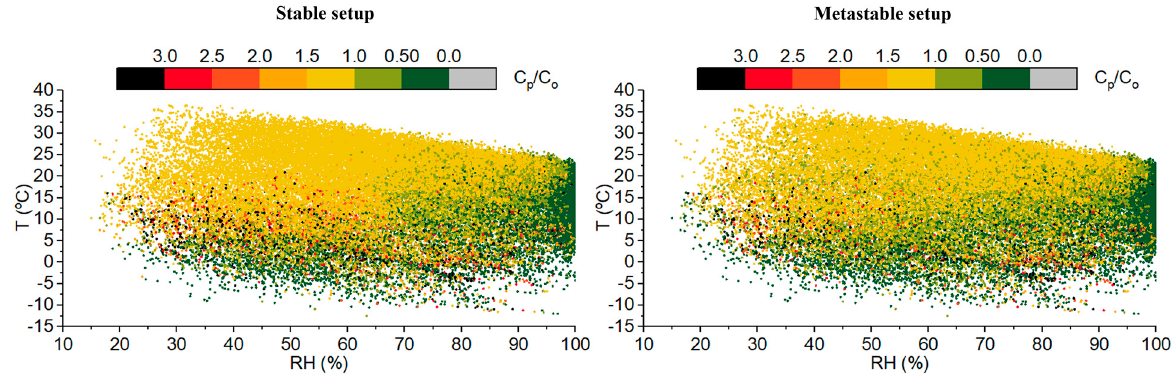
Figure 3. The ratios of C p /C o for HNO 3 prediction using stable and metastable model setups.